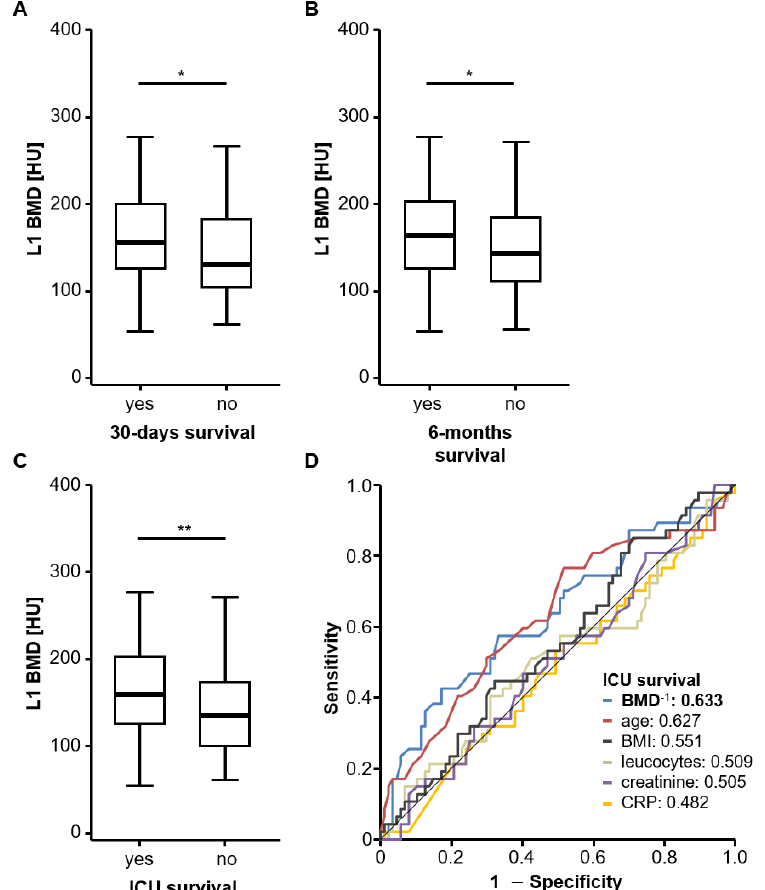
Figure 3. Low BMD is associated with higher short-term mortality in critically ill patients. ( A ) BMD values are significantly lower in ICU patients who died within the first 30 days after ICU admission.